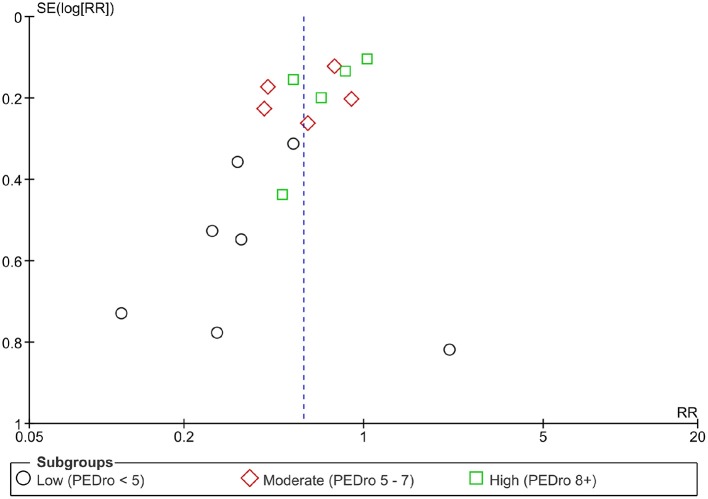
Funnel plot; SE, standard error, RR, relative risk.